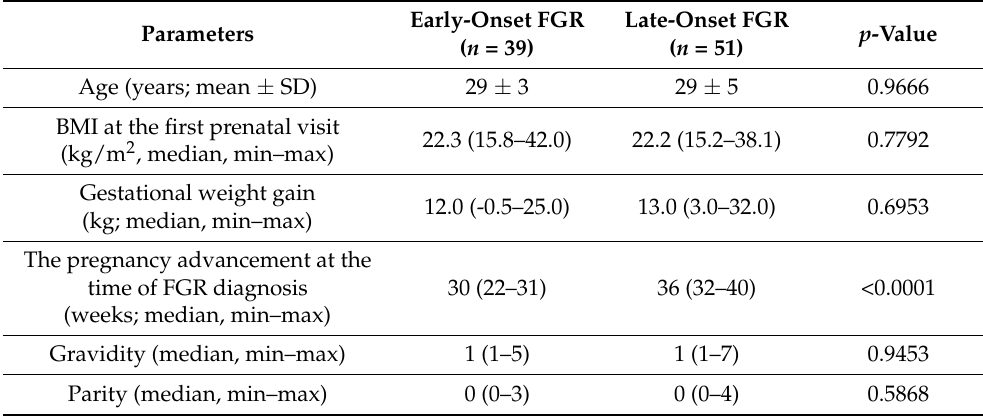
Table 1. The characteristics of the early-onset and late-onset FGR group.